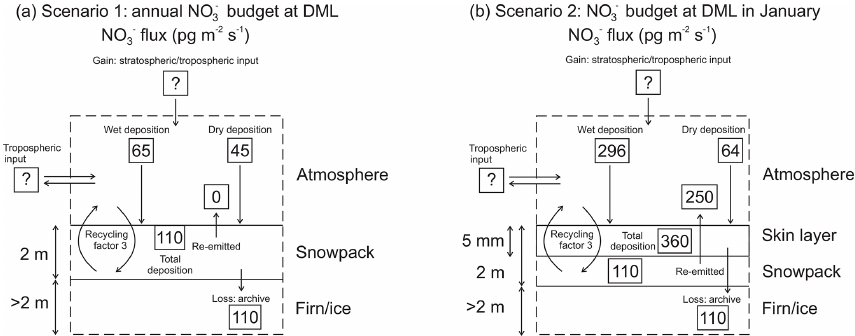
Figure 6. Schematic of NO − mass fluxes at Dronning Maud Land (DML) for (a) annual mean scenario and (b) January scenario. 3